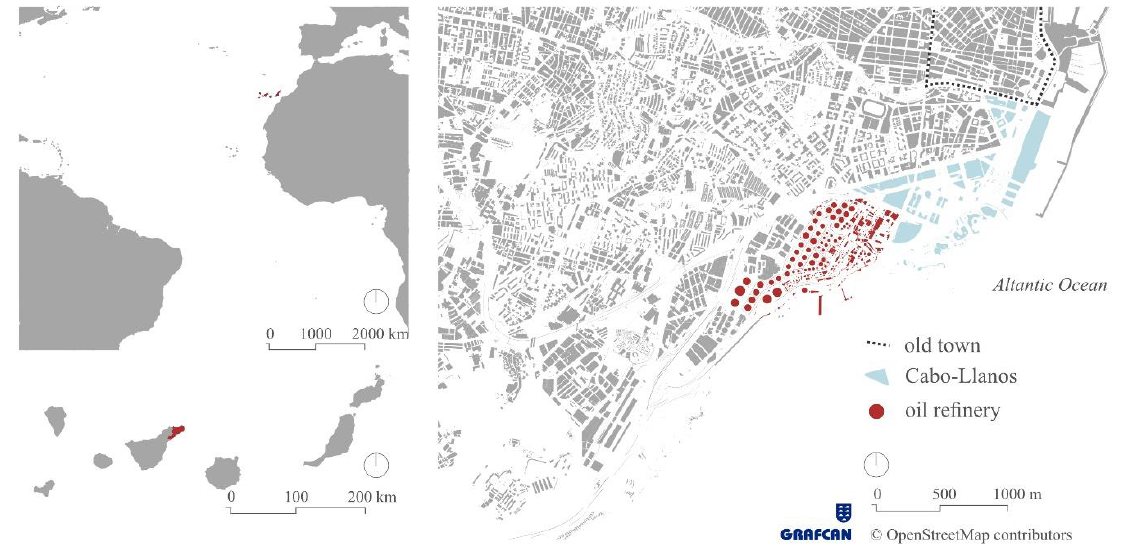
Figure 1. The geographical setting of the oil refinery and the Cabo-Llanos neighborhood, which formed part of the refinery until the 1990s. Own elaboration based on Open Street Map [6] and Grafcan [7].